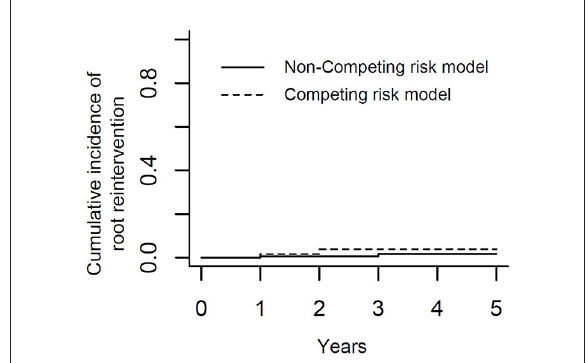
FIGURE4 Competing risk analysis of freedom from aortic root